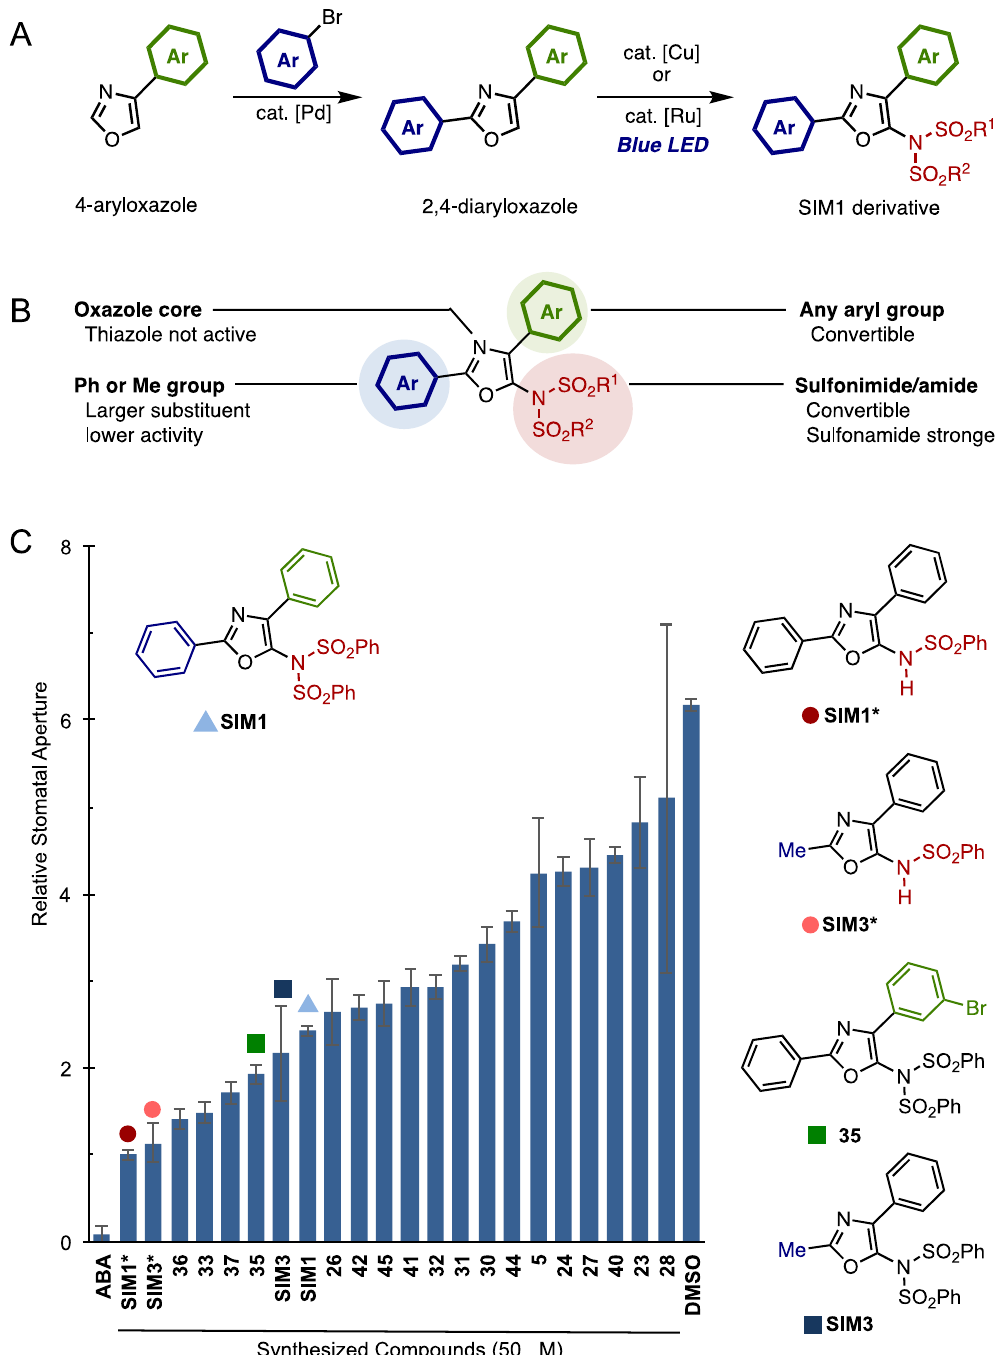
Figure 4. Synthesis and evaluation of SIM1 derivatives for structural activity relationship (SAR) study. ( A ) Synthesis of SIM derivatives. ( B ) Summary of SAR study. ( C ) Inhibition of light induced stomatal opening by SIM1 derivatives evaluated in C. benghalensis . Stomatal apertures were measured after 3 h of light irradiation in the presence of the indicated compounds (50 µM). Values are relative to values of SIM1* treated stomatal apertures. ABA 10 µM Abscisic acid, positive control. Mean ± SD (n >